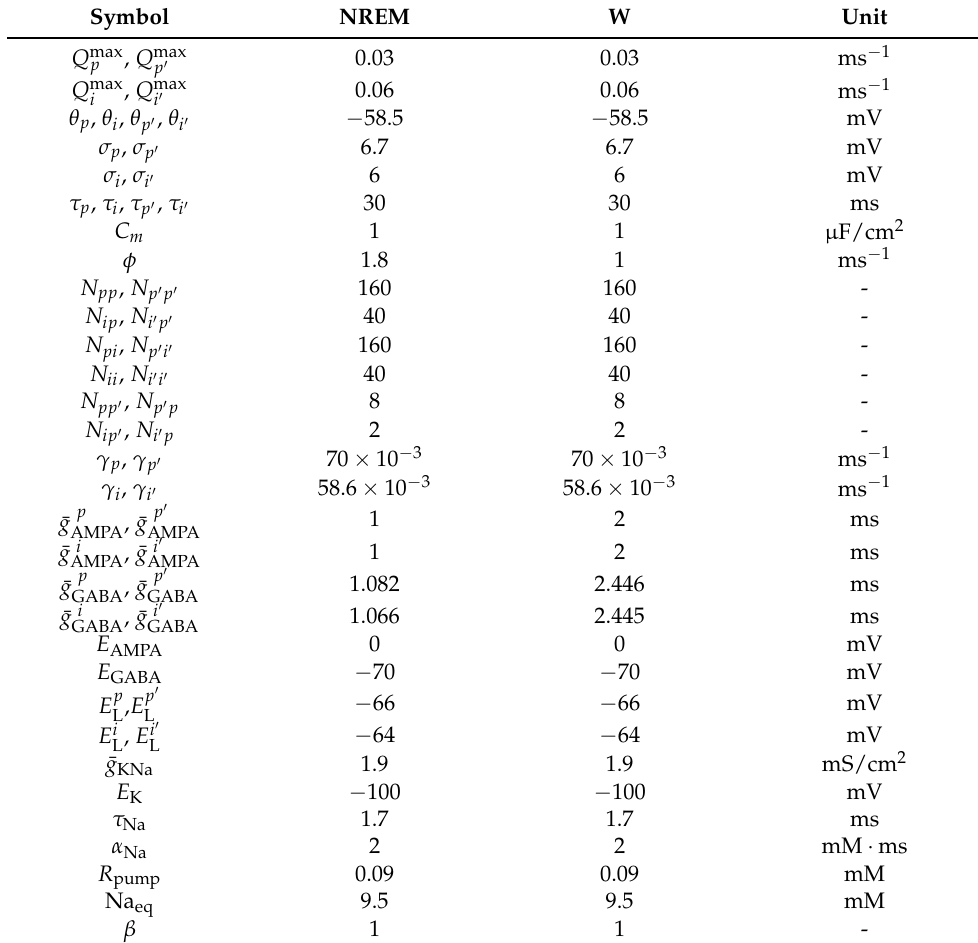
Table 3. Parameter values for the two-cortical-column